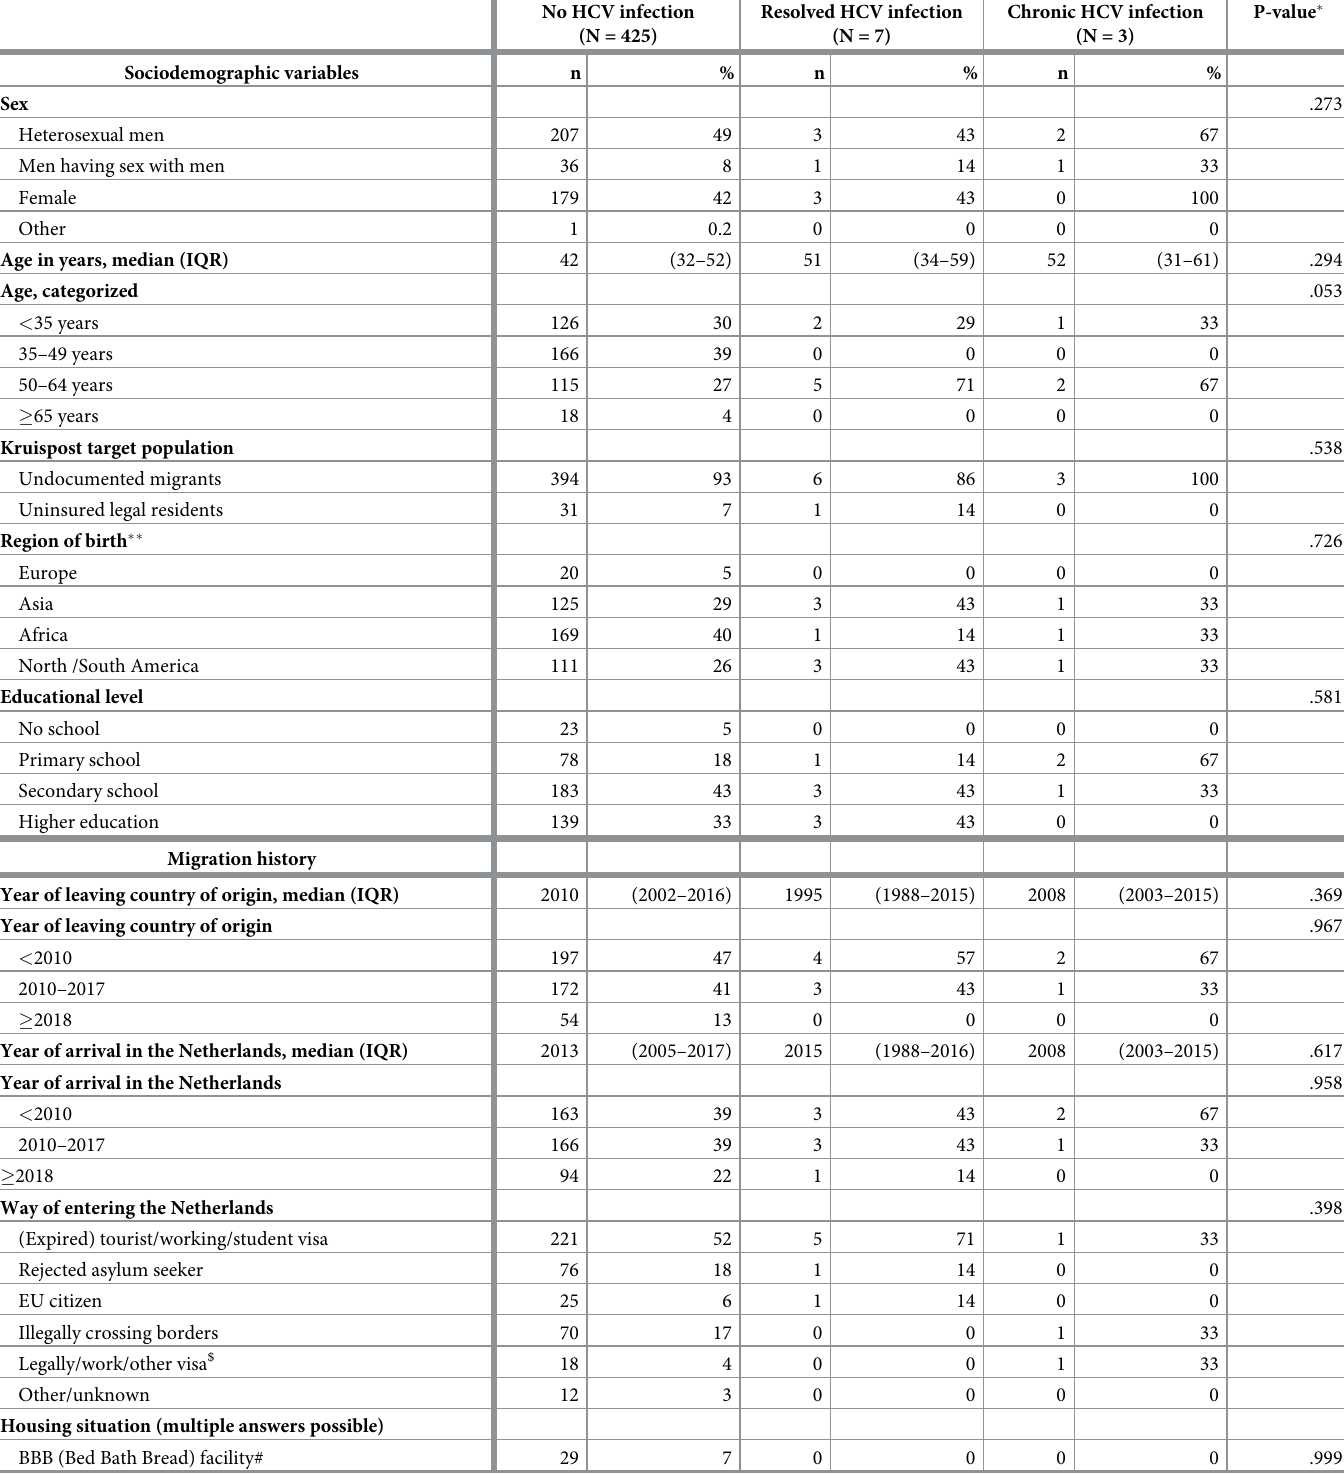
Table 5. Characteristics of undocumented migrants and uninsured legal residents tested for HCV (N = 435) by HCV status, in Amsterdam, the Netherlands, Octo- ber 2018- October